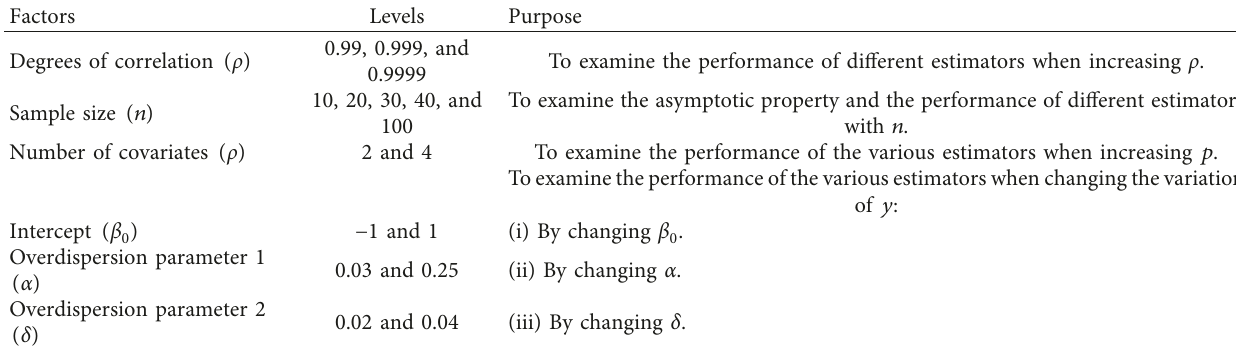
when δ � 0 . 02 , α � 0 . 03 , and p � 2. 0 ρ � 0 .